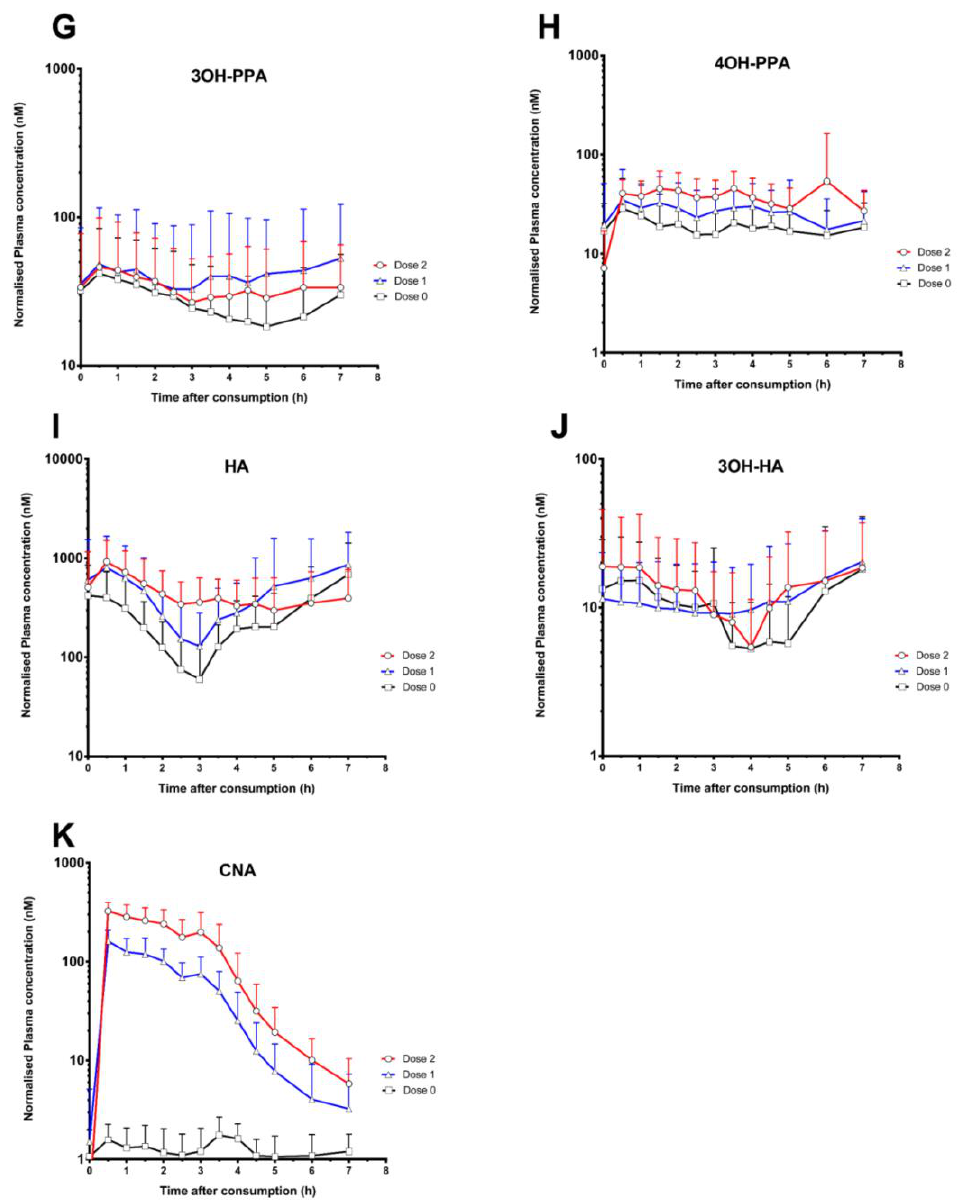
Figure 1. Normalized logarithmic plasma concentration-time curves of 11 phenolic/aromatic acids, specifically ( A ) benzoic acid (BA); ( B ) 4-hydroxybenzoic acid (4OH-BA); ( C ) phenylacetic acid (PAA); ( D ) 3-hydroxyphenylacetic acid (3OH-PAA); ( E ) 4-hydroxyphenylacetic acid (4OH-PAA); ( F ) 3-phenylpropanoic acid (PPA); ( G ) 3-(3-hydroxyphenyl)-propanoic acid (3OH-PPA); ( H ) 3-(4-hydroxyphenyl)-propanoic acid (4OH-PPA), ( I ) hippuric acid (HA); ( J ) 3-hydroxyhippuric acid (3OH-HA); and ( K ) cinnamic acid (CNA).